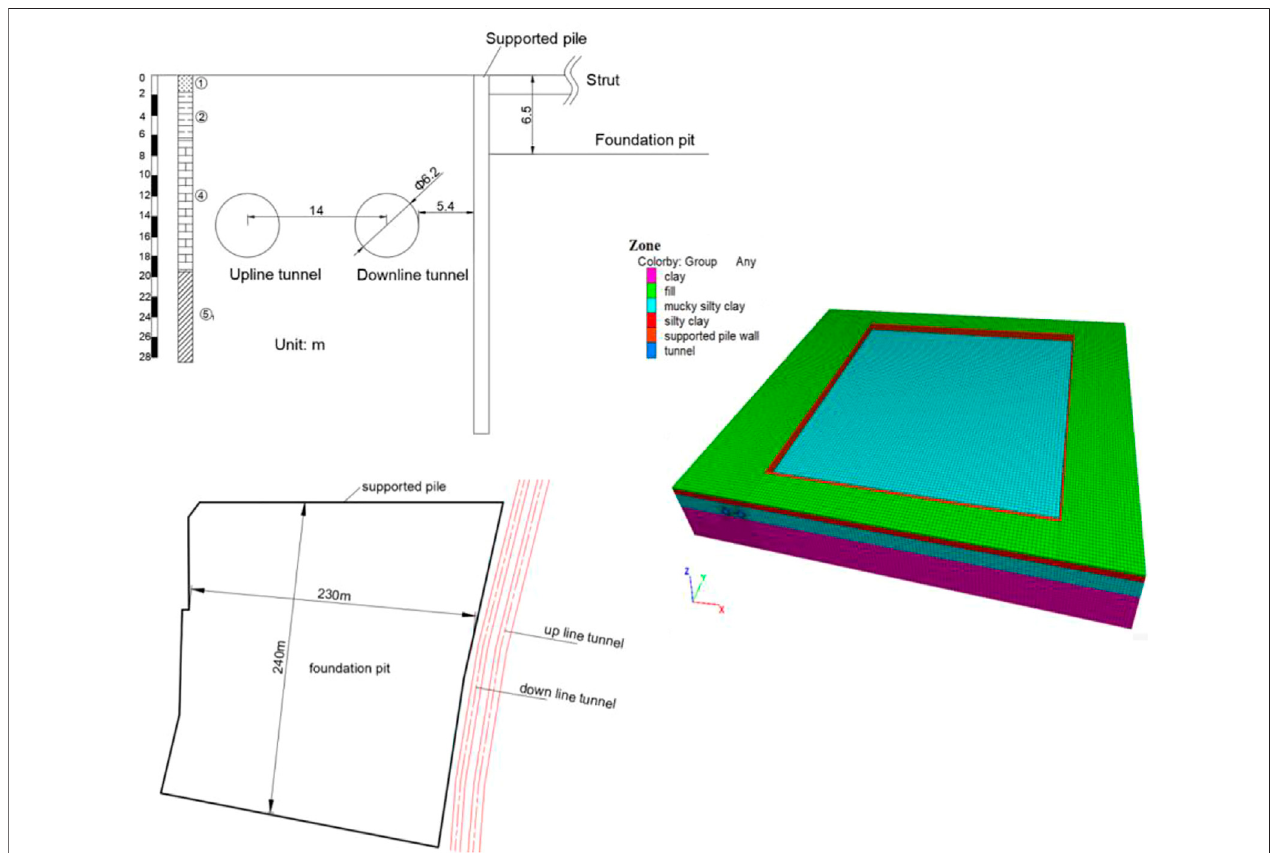
FIGURE 6 | The numerical model according to the project layout in Case I.